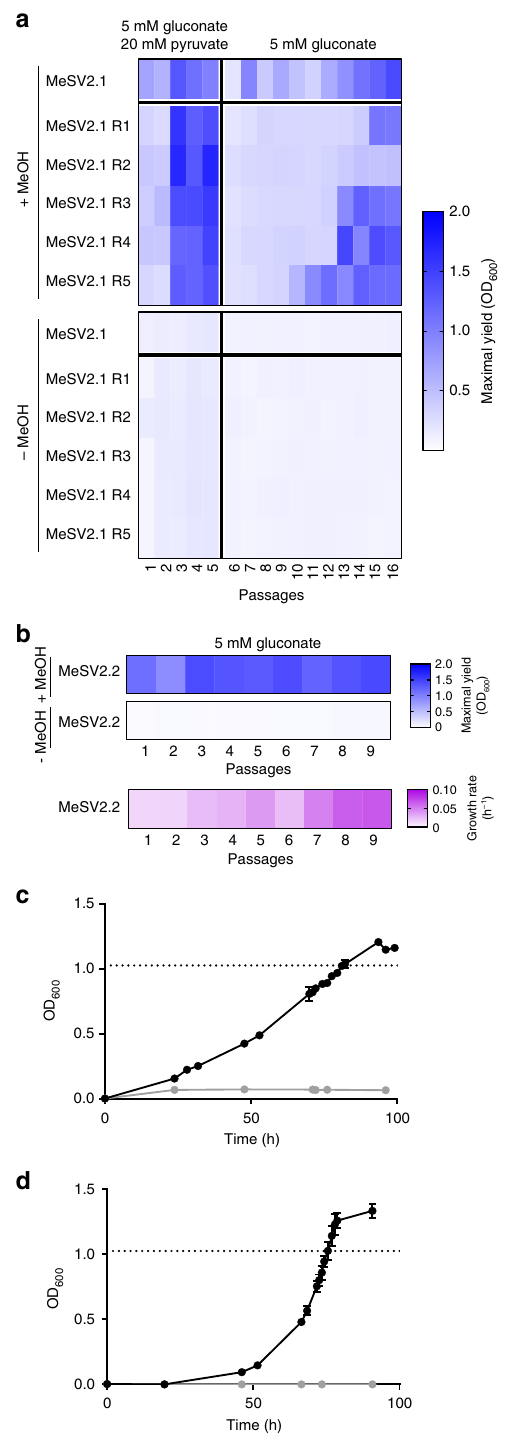
Fig. 4 Evolution of methanol-essential strain version 2 (MeSV2). MeSV2 ( Δ edd Δ rpiA Δ rpiB Δ maldh pSEVA424 mdh2 PB1 pSEVA131 hps phi Mf) was evolved on 5 mM gluconate, and for the fi rst fi ve passages, with 20 mM MeSV2 with or without 500 mM methanol and with 0.1 g L − 1 yeast extract ( a ) or without yeast extract ( b ). The growth rate of cultures are shown in pink. Growth curves of the evolution endpoint with (black) and without (gray) methanol for strains MeSV2.1 on 5 mM gluconate with 0.1 g L − 1 yeast extract ( c ) and MeSV2.2 on 5 mM gluconate without yeast extract ( d ); n = 3. Data are presented as mean ± standard deviation. Dotted